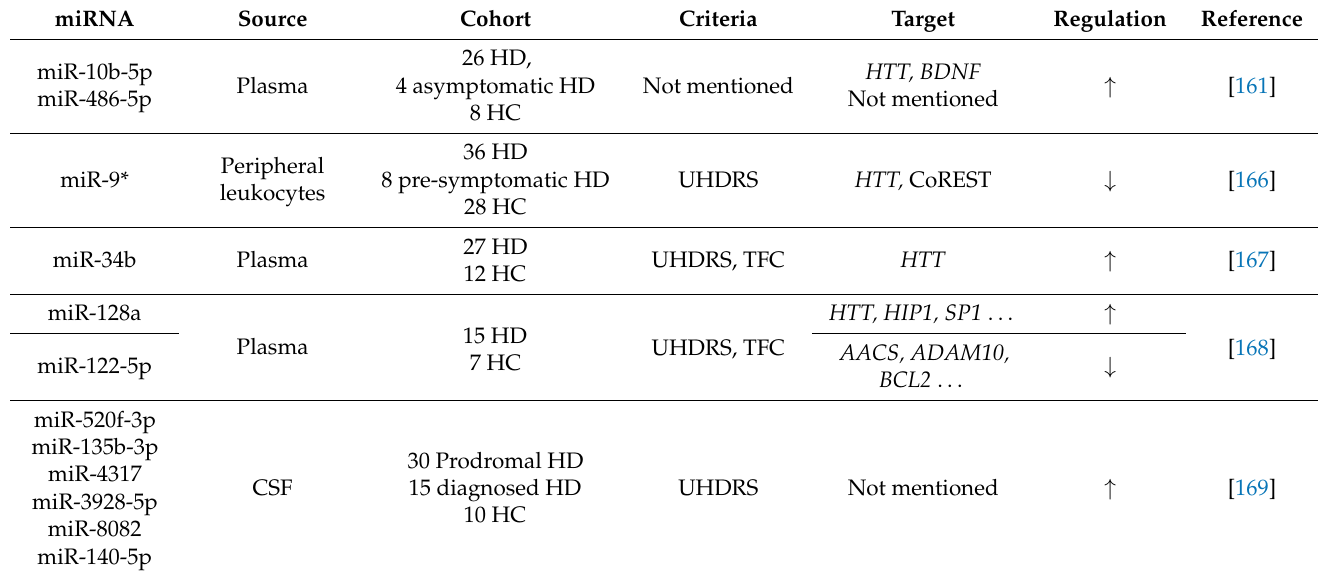
Table 5. Profile of miRNAs proposed as Huntington’s disease